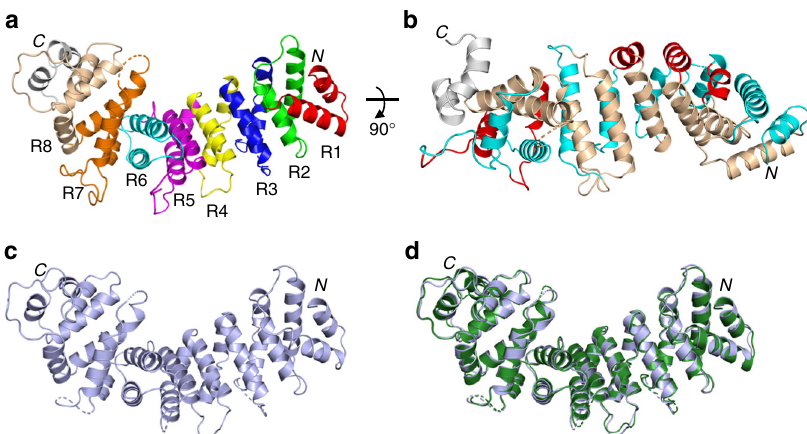
Fig. 2 Structure of the Ric8A armadillo core. Structure of Ric8A1 – 426 based on the Ric8A1 – 492/MBP-G α t 327 – 350 complex. a ARM repeats R1 – 8 are shown in different colors, as indicated. b α -helices h1, h2, and h3 comprising each ARM-repeat are shown in red, cyan, and wheat, respectively. The two- helix hairpin of Ric8A (residues 400 – 426) is shown in gray. c Structure of apo Ric8A1 – 492 in which only residues 1 – 422 were resolved. d Overlay of the structures in ( a ) and ( c